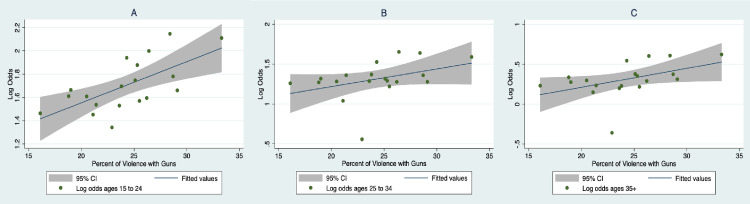
Plots and best fitting linear relations between percentages of gun use in violent TV segments and log odds of homicides attributable to firearms for persons (A) ages 15–2, (B) ages 25–34, and (C) ages 35+ from 2000 to 2018.